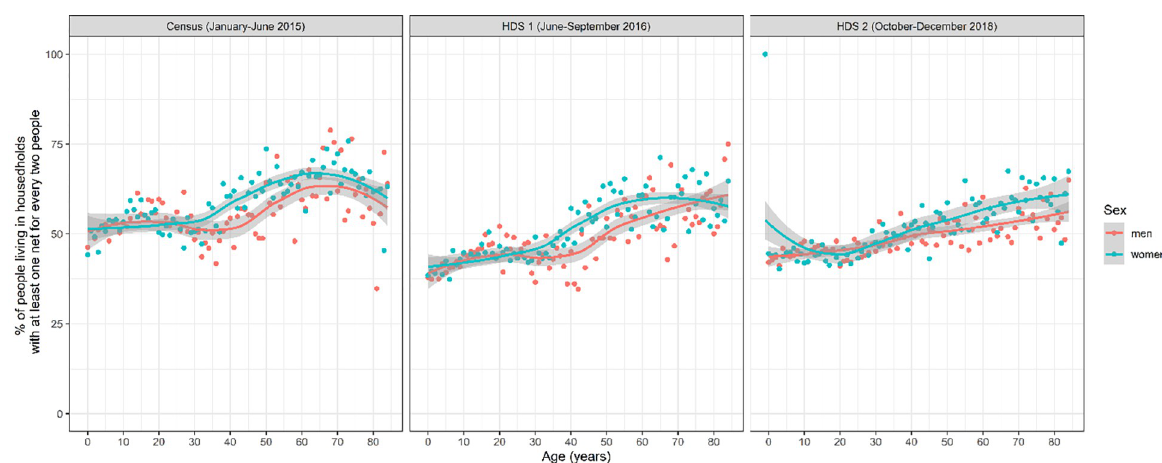
Fig 2. Percentage of people living in households with at least one LLIN for every two people, segregated by gender and age. Grey shaded areas represent the locally estimated scatterplot smoothing of the curves.